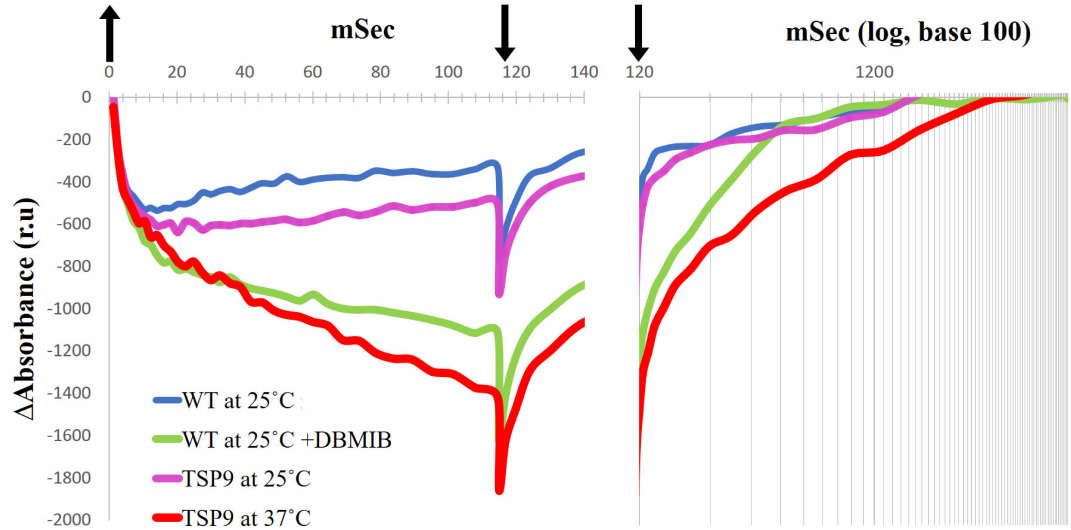
Figure 5. Absorbance records in relative units (ru) for light-induced P700 photooxidation (left panel) and P700+ dark-reduction (right panel, with time presented with a logarithmic scale) of the wild type (WT) and TSP9 Chlamydomonas reinhardtii cells (arrows: up, light ON; down, light OFF). P700 kinetics of the WT cells that were grown at the permissive temperature of 25 ◦ C (blue line), and in the presence of 0.1 mM DBMIB (green line) are compared with P700 kinetics of TSP9 cells grown at the permissive (magenta line) and non-permissive (red line) temperatures. The chlorophyll concentration for each measurement was balanced to 0.1